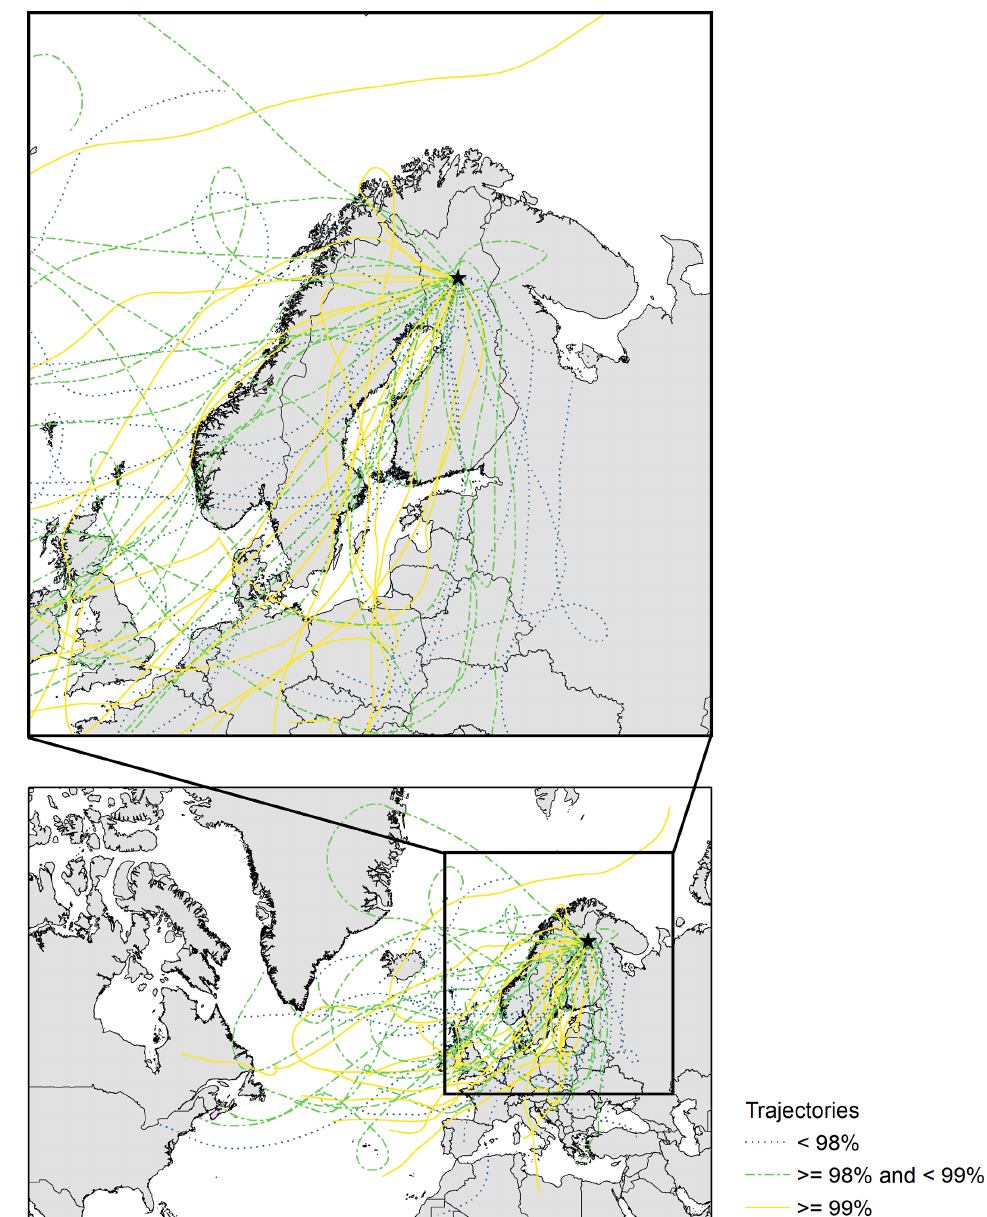
Figure 10. Five-day backward trajectories (lines) arriving at the measurement site in Sodankylä, Finland (black star) at 2.7km aboveground at full hour (i.e. 11:00 or 23:00UTC) for each of the 52 snowfall events. The group of maximum running mean RH water (as in Fig. 9) is shown in colour ( < 98%, dotted blue; ≥ 98% and < 99%, dashed green; < 99% continuous yellow). An inset map is shown in the upper panel. The trajectories were calculated using the NOAA’s Hybrid Single-Particle Lagrangian Integrated Trajectory (HYSPLIT) model. One trajectory per event was computed using the GDAS 1 ◦ meteorology dataset and the “model vertical velocity” vertical motion